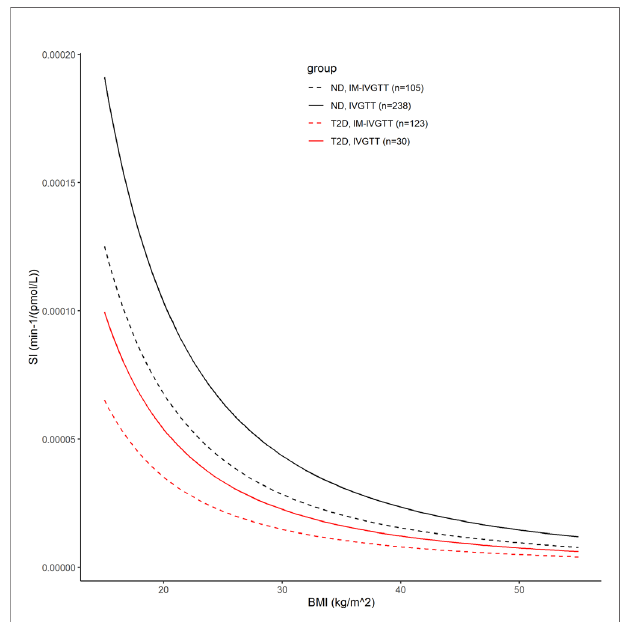
FIGURE 4 | The black lines show the covariate model prediction of the typical value of S I versus BMI in ND subjects, with the solid line indicating subjects in IVGTT and dash line indicating IM-IVGTT. The red lines are the corresponding curves in T2D